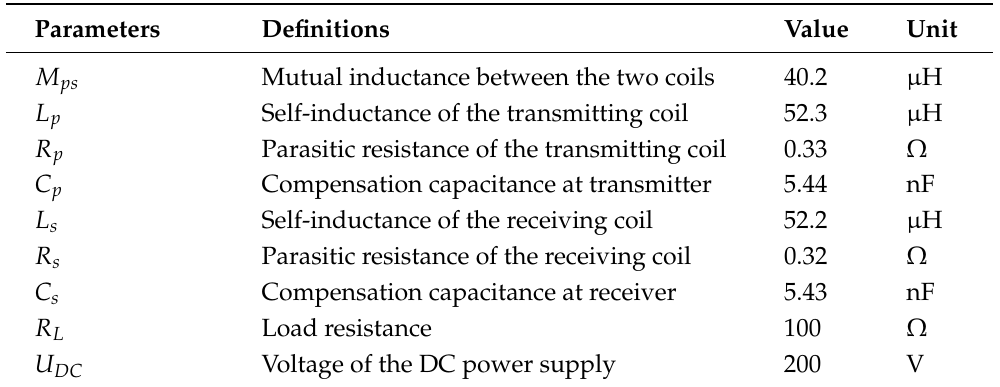
Table 1. Parameters of the